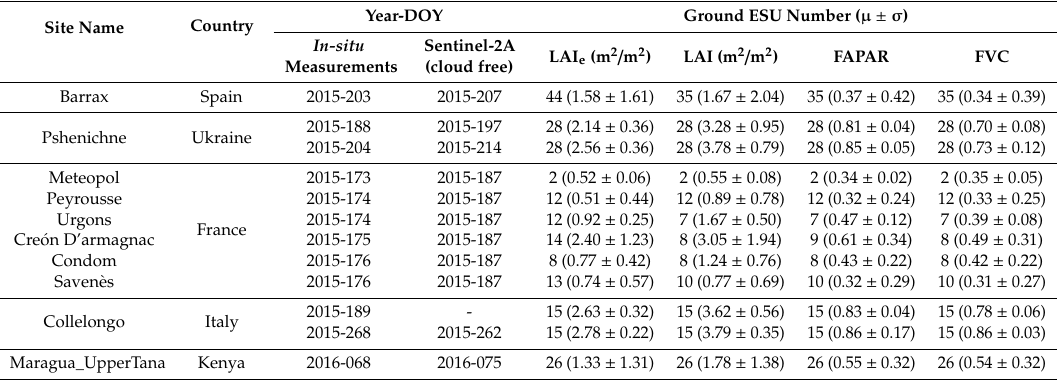
Table 1. The acquisition dates (Year-DOY (Day of Year)) of in situ measurements and Sentinel-2A images. The number, average ( µ ) and standard deviation ( σ ) of ground ESUs are reported in the last 4 columns. The “-” indicates that no available satellite data at this site.